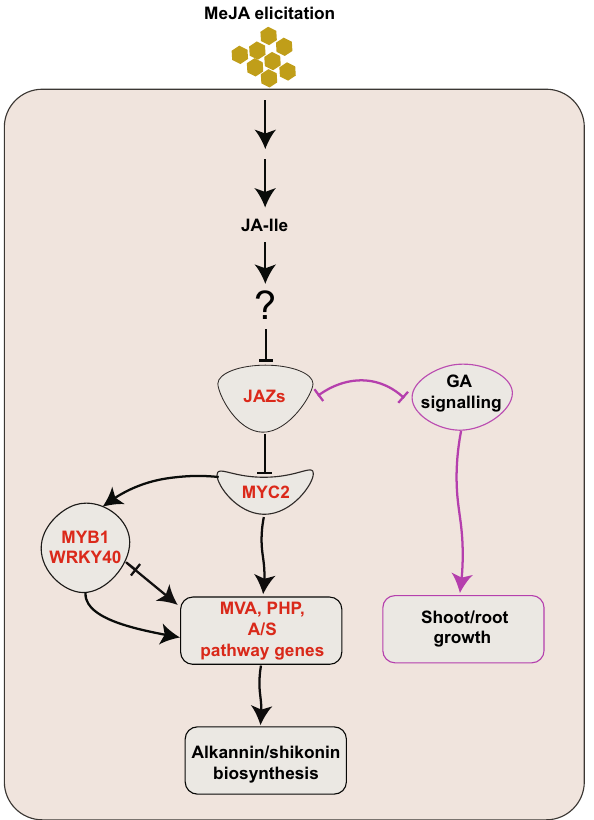
Figure 7. Hypothetical model of MeJA mediated A/S biosynthesis and growth reduction in L. officinale . MeJA elicitation leads to increased biosynthesis of JA-Ile which might be perceived by unidentified COI1 receptors leading to degradation of JAZs and relieving repression of MYC2. MYC2 might then directly upregulate the expression of precursors (mevalonate and/or phenylpropanoid) and/or A/S pathway genes leading to enhanced A/S biosynthesis. LeMYB1 and WRKY40 might directly increase the expression of pathway genes (crossed arrow) or interact with MYC2 to regulate A/S biosynthesis. Cross talk of MeJA-mediated JAZs with GA signalling might have led to the reduced growth of L. officinale . Blunt arrows represent inhibitory effects while complete arrows depict promoting effects. Red letters show genes that coexpressed in the red